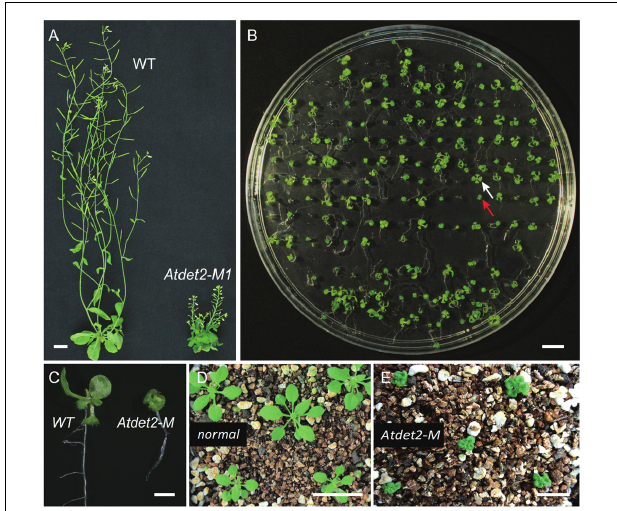
FIGURE 2 | Phenotypic analyses of Atdet2-M mutants generated by the MSC system. (A) Phenotypes of wild type plant and targeted editing Atdet2 mutant plant. Both have grown for 45 days before photographing. Bar = 1 cm. (B) Phenotypic segregation of T2 plants. The white arrow points a seedling with normal like phenotype, and the red arrow points an Atdet2 mutant seedling with small and dark-grown leaves. Plants have grown for 12 days on 1/2 Murashige and Skoog (MS) medium before photographing. Bar = 1 cm. (C) Phenotypes of wild type plant and targeted editing Atdet2 mutant plant. Plants have grown on 1/2 MS medium for 12 days. Bar = 1 mm. (D) Phenotypes of normal like plants grown for 20 days in soil. Bar = 1 cm. (E) Phenotypes of Atdet2 mutants grown for 20 days in soil. Bar = 1 cm.